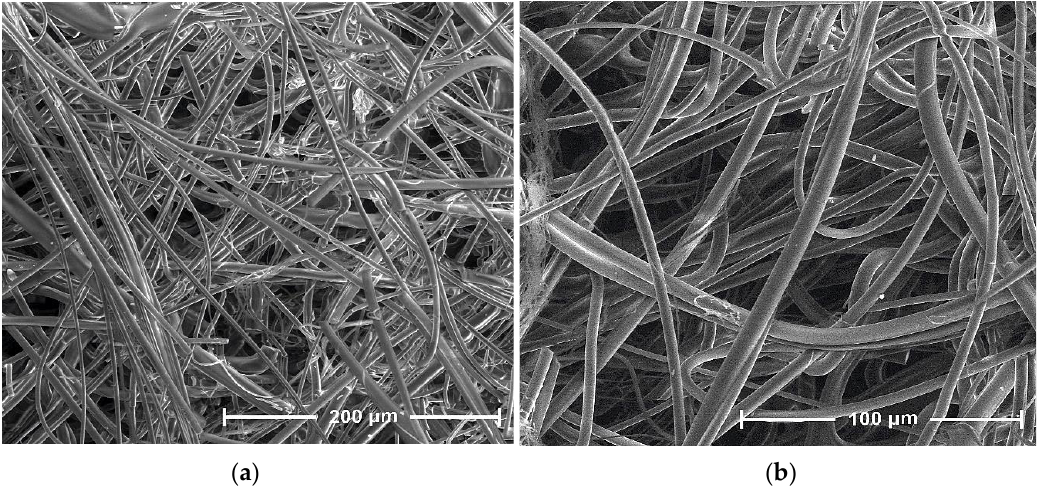
Figure 4. SEM images of PLA, magnification: ( a ) 800× and ( b ) 1600×.